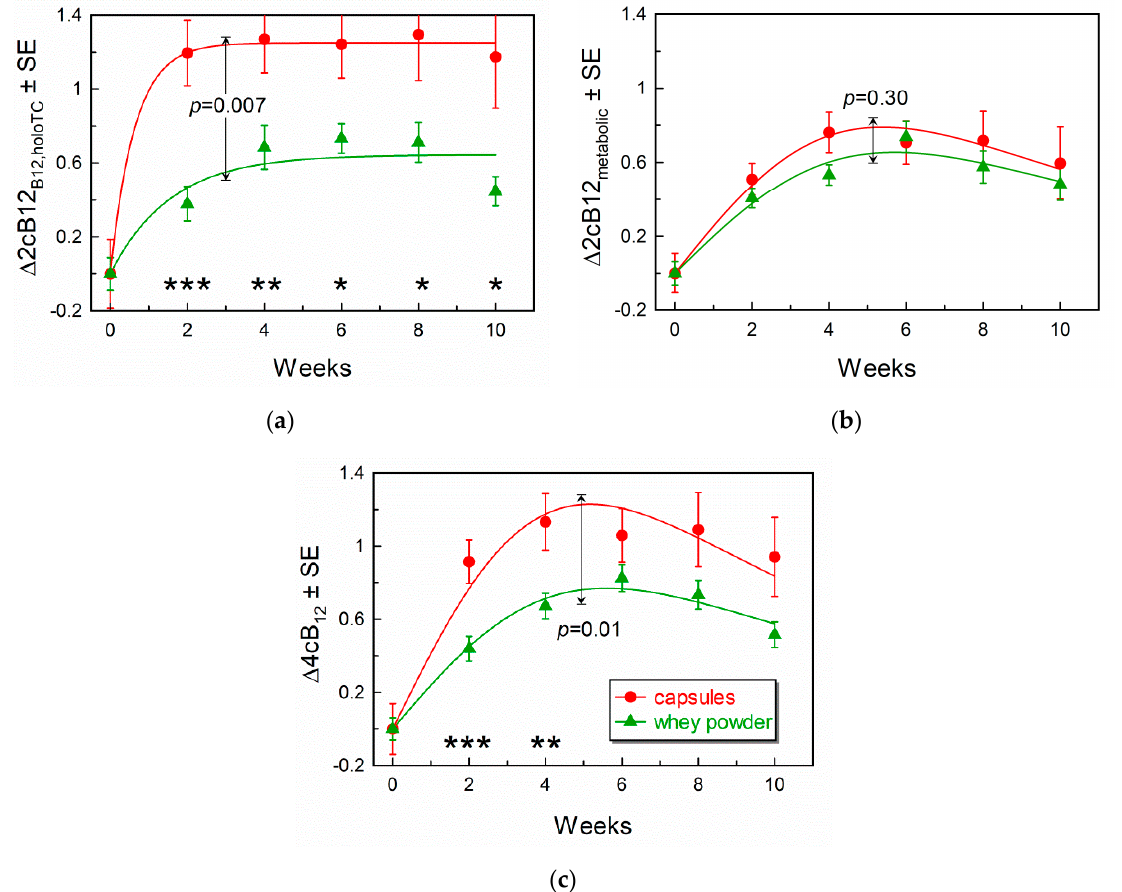
Figure 4. Changes in the combined indexes of B12 status during supplementations with CN-B12 in capsules or HO-B12 in whey powder. ( a ) Partial “vitamin” indexes 2cB12 for total B12 and holoTC, fitted by Equation (1). ( b ) Partial “metabolic” indexes 2cB12 for total Hcy and MMA, fitted by Equation (2). ( c ) Full indexes 4cB12 fitted by Equation (2). Other annotations as stated for Figure 2.